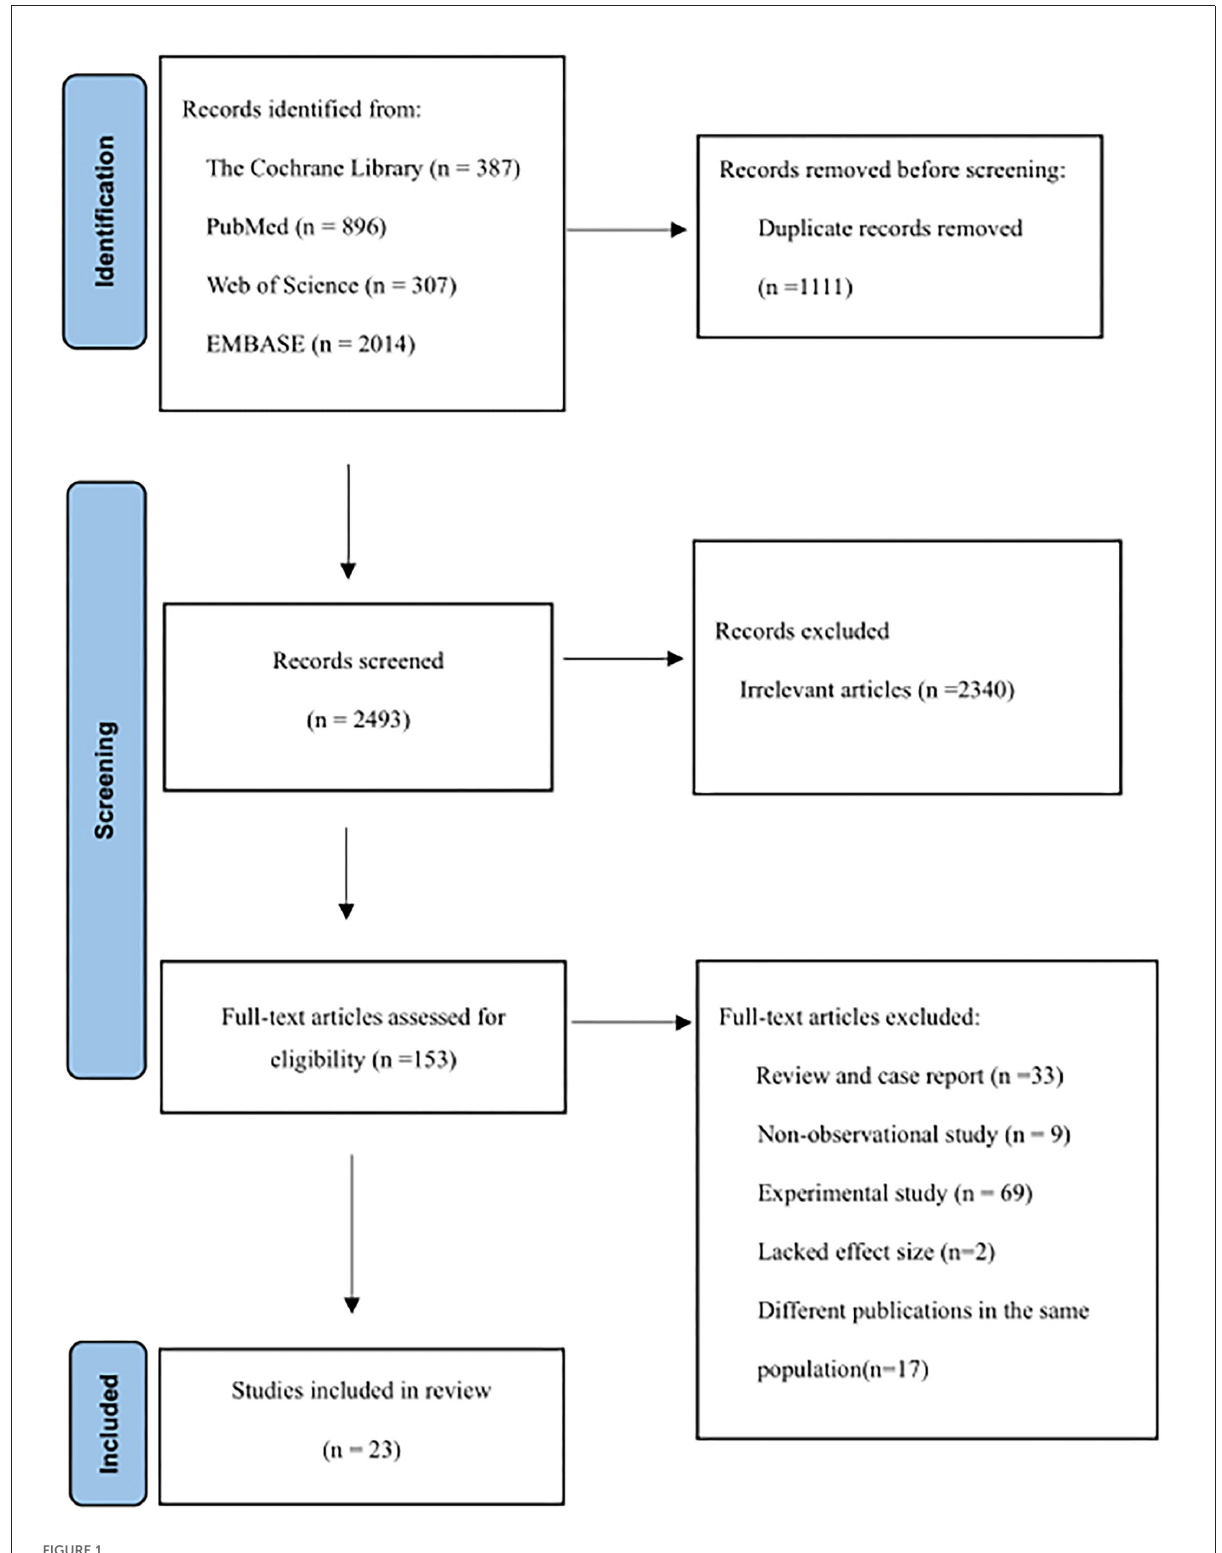
FIGURE1 Flow diagram outlining the systematic search and articles selection